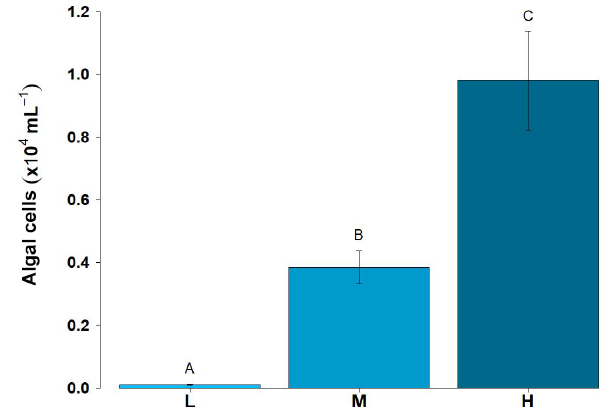
Figure 6. Algal cell abundance in ice surface ice habitats (mean ± SE, n = 19 for each habitat). L – ice with low visible impu- rities, M – ice with medium visible impurities and H – ice with high visible impurities. Uppercase letters denote homogeneous subsets derived from post hoc Tukey HSD analysis on a significant one-way ANOVA in relation to habitat